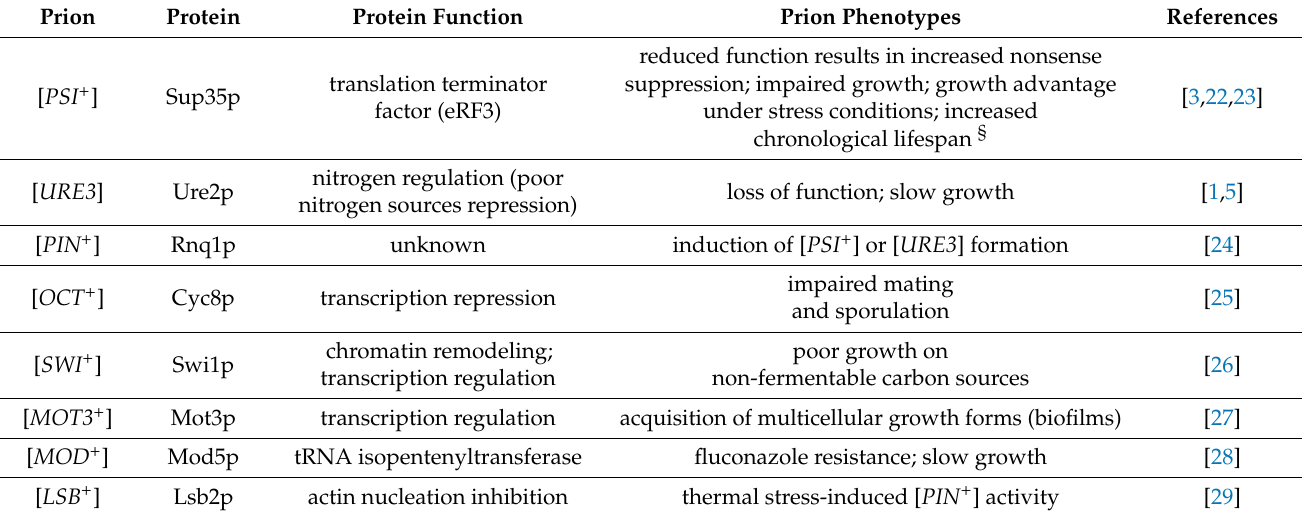
Table 1. Amyloid-based prions in the yeast Saccharomyces cerevisiae (adapted from [8,10,21]). Prion